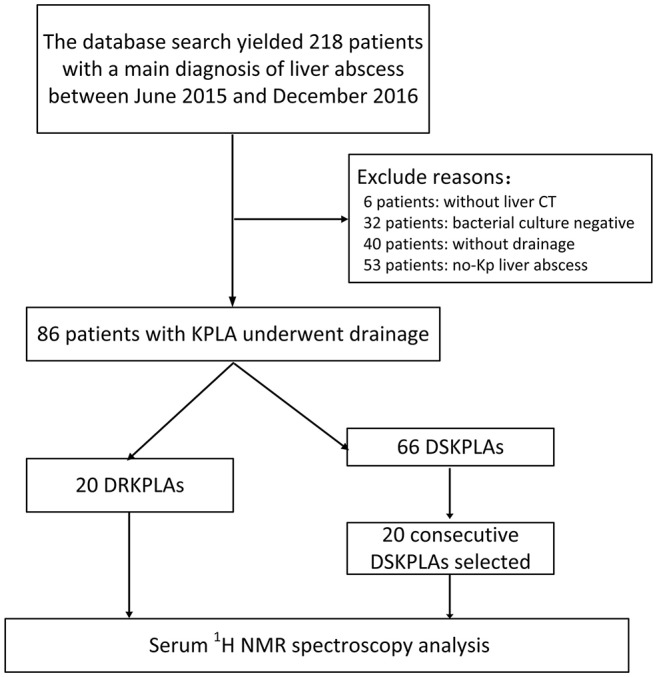
Flow chart of the patient selection.